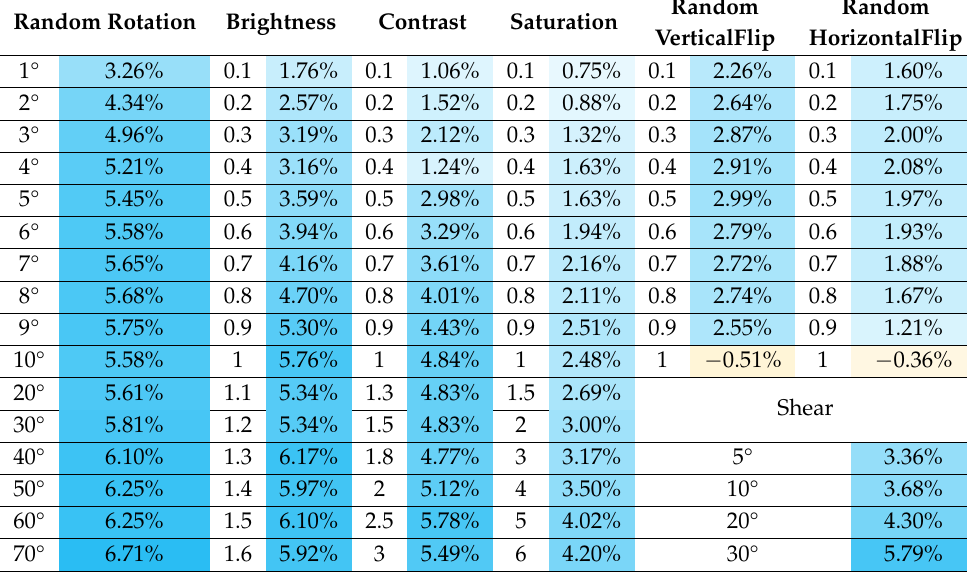
Table A3. Performance of DA methods on Γ train 50 with setting seed to 3500. This heatmap shows PAP the effect of different DA methods and parameters on the average accuracy improvement of Γ train 50 PAP when setting seed to 3500. The displayed percentage values describe the increase/decrease of mAA in percent. The value is color-coded from blue (increase in accuracy) over white (no effect) to orange (decrease in accuracy). DA methods show a similar trend to that at seed is